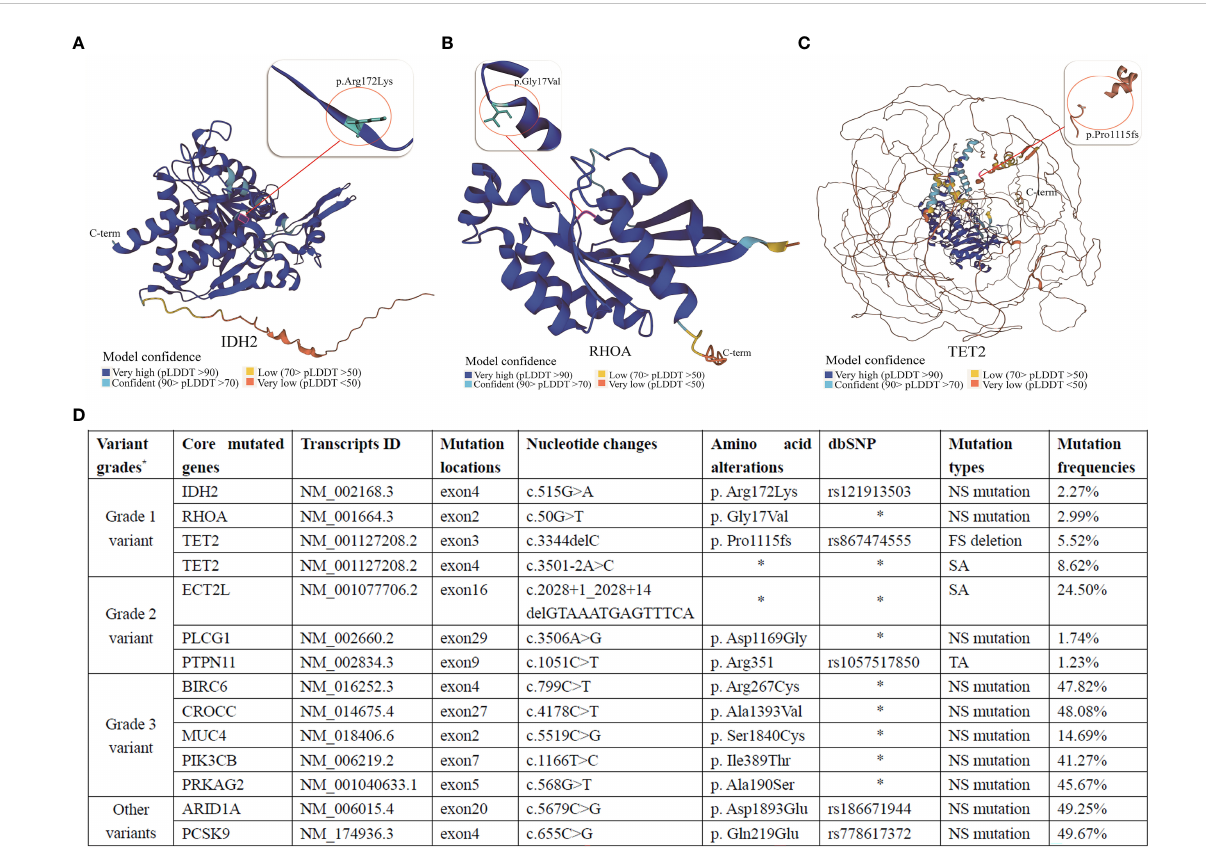
FIGURE 4 Gene mutations detected in the patient: (A) . IDH2, (B) . RHOA, and (C) . TET2. (D) . Speci fi c information on the primary mutated genes provided by the sequencing company. NS mutation, non-synonymous mutation; FS deletion, frame-shift deletion; SA, spliceosome abnormalities; TA, terminator